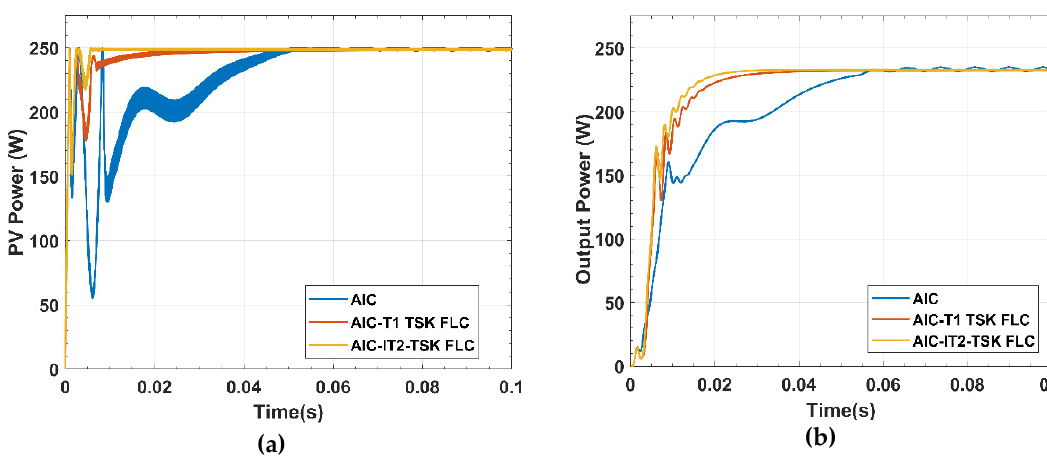
Figure 9. Output power responses of PV panel ( a ) and converter ( b ) for Case 1.